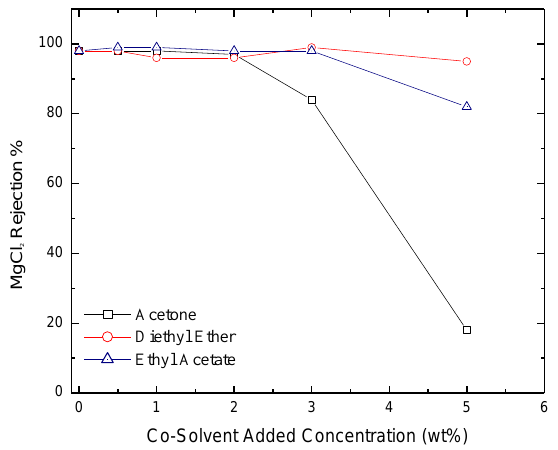
Figure 12. Salt rejection of MgCl 2 through membranes formulated with acetone, diethyl ether, and ethyl acetate added as co-solvents.